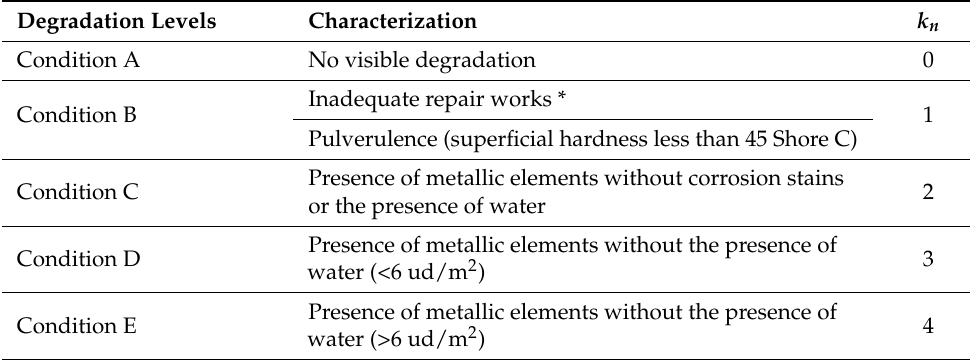
Table 3. Classification of constructive